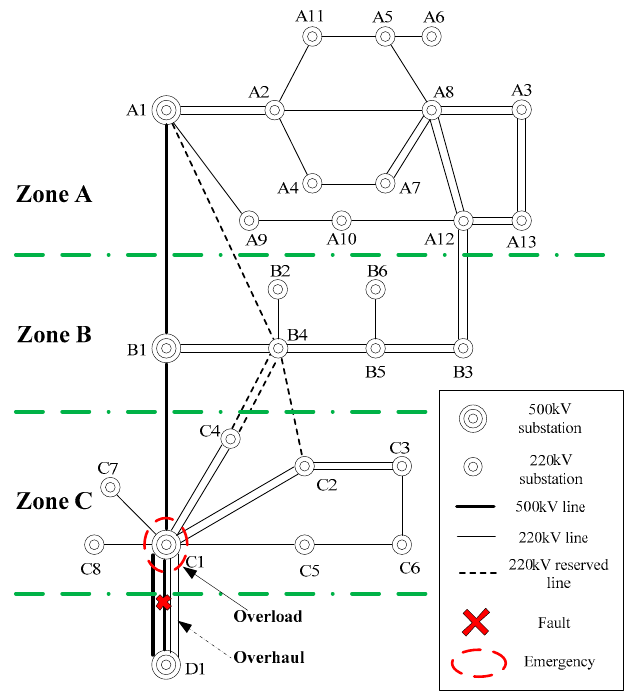
Figure 2. Topology of the power system with overload emergency in Case 1. Table 2. Switching devices in Case 1.